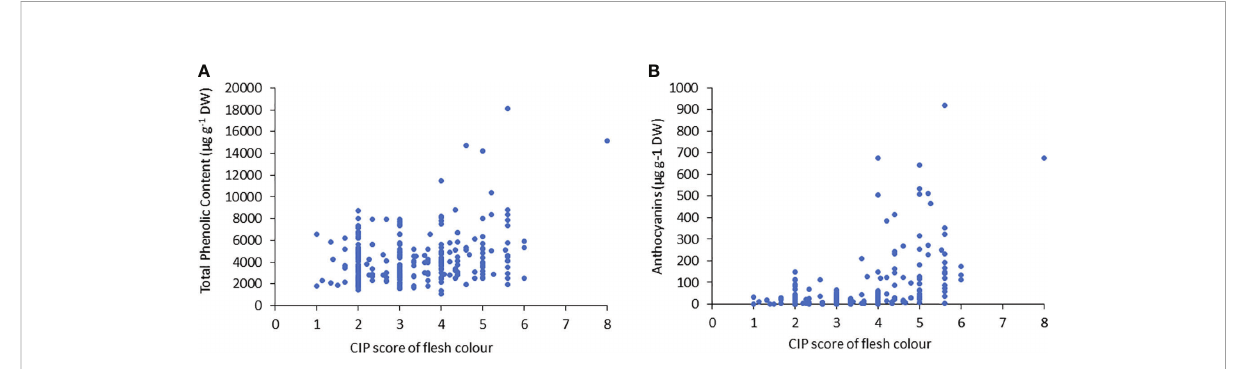
FIGURE 3 Correlation between (A) the total phenolic content (TPC) and (B) anthocyanin content, related to tuber fl esh colors with the CIP